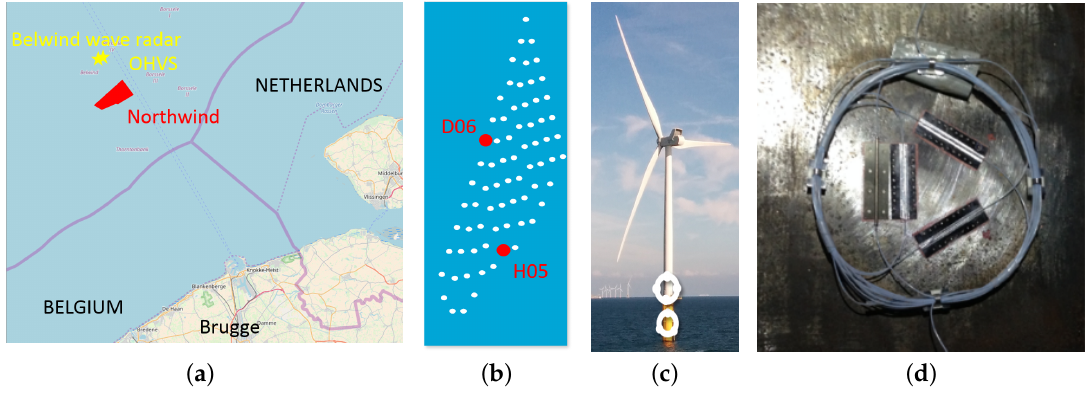
Figure 3. Illustration of the investigated turbines, the metocean stations, and the measurement set-up. ( a ) Location of the wind farm Northwind and the used metocean stations ( c (cid:13) OpenStreetMap contributors (openstreetmap.org) Copyright: CCBY-SA). ( b ) Northwind layout with both instrumented